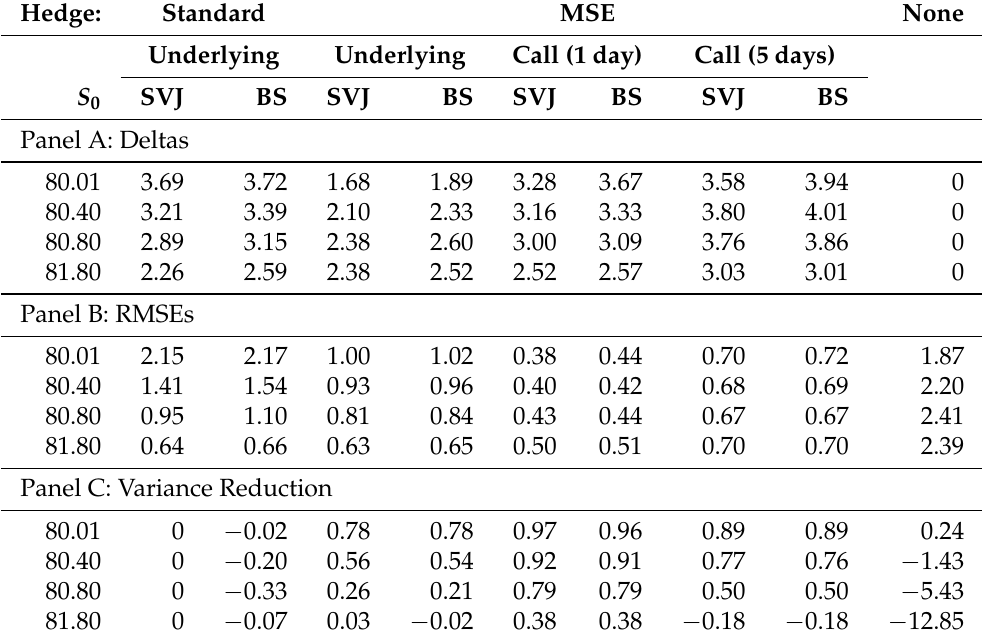
Table 1. SVJ model with overnight trading gap: deltas, absolute root mean squared hedging error, and variance reduction. Hedging object is a down-and-out put with K = 100, B = 80, and T = 20 days; the hedging period is ∆ t = 1 day. The different strategies are model delta, MSE delta using the underlying and MSE delta using vanilla calls with time to maturity of 1 or 5 days, and no hedging. For each strategy, hedges are calculated with the correctly specified model (SVJ) and as an approximation with the semi-analytical formulas in the Black–Scholes model